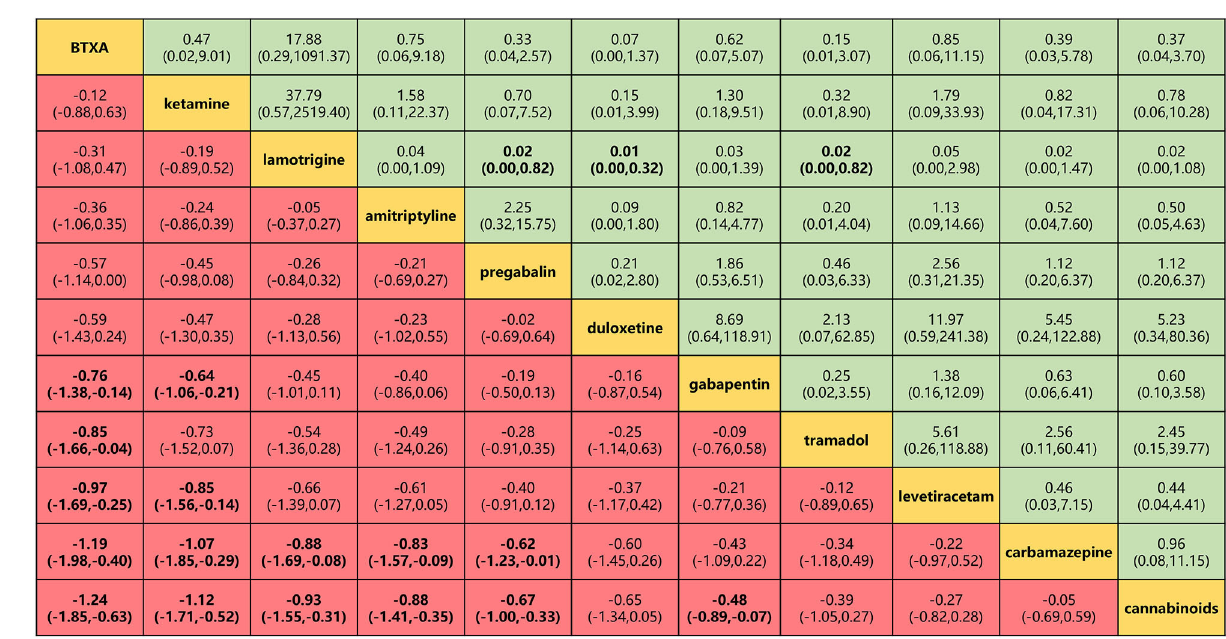
FIGURE 5 | Head-to-head comparisons for efficacy and safety (primary outcomes) of 11 drugs. Drugs are reported in efficacy order sorted from top left to bottom right. Data are SMD (95% CrI) and OR (95% CrI) in the column-defining treatment compared with the row-defining treatment. For efficacy (pain relief for around 4 weeks), SMD lower than 0 favors the column-defining treatment. For safety (adverse events), OR lower than 1 favors near the top left one. To obtain OR for comparisons in the opposite direction, reciprocals should be taken. Significant results are in bold. SMD, standard mean deviation; OR, odds ratio; CrI, credible interval; BTXA, botulinum